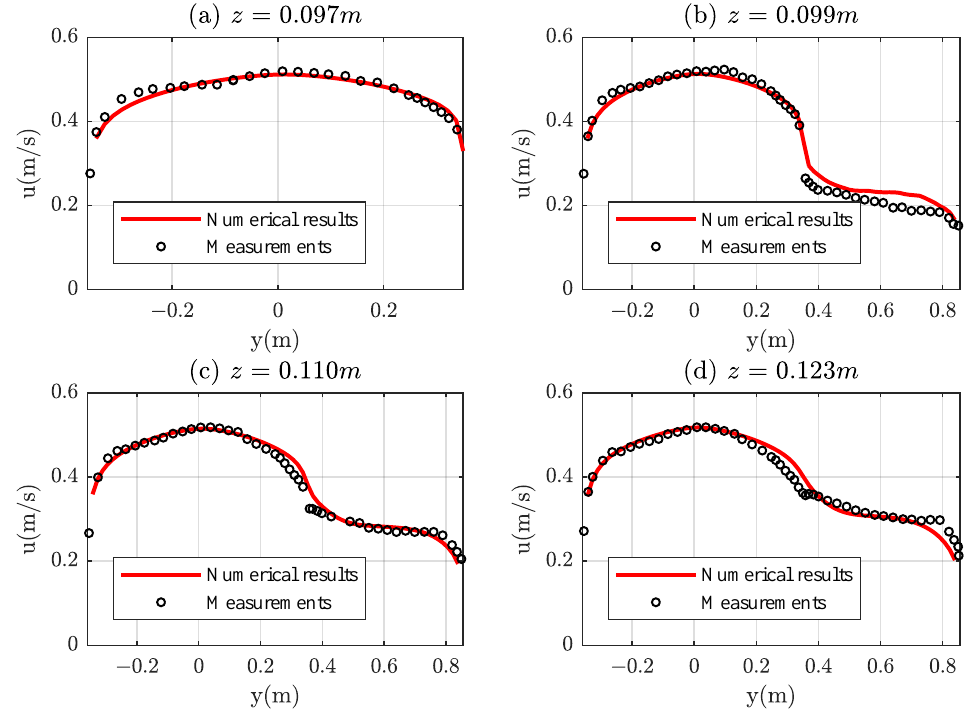
Figure 9. Comparison of calculated and measured horizontal velocity profiles in a compound channel of the experiments of Rajaratnam and Ahmadi [38]: ( a ) z = 0.097 m; ( b ) z = 0.099 m; ( c ) z = 0.11 m; and ( d ) z = 0.123